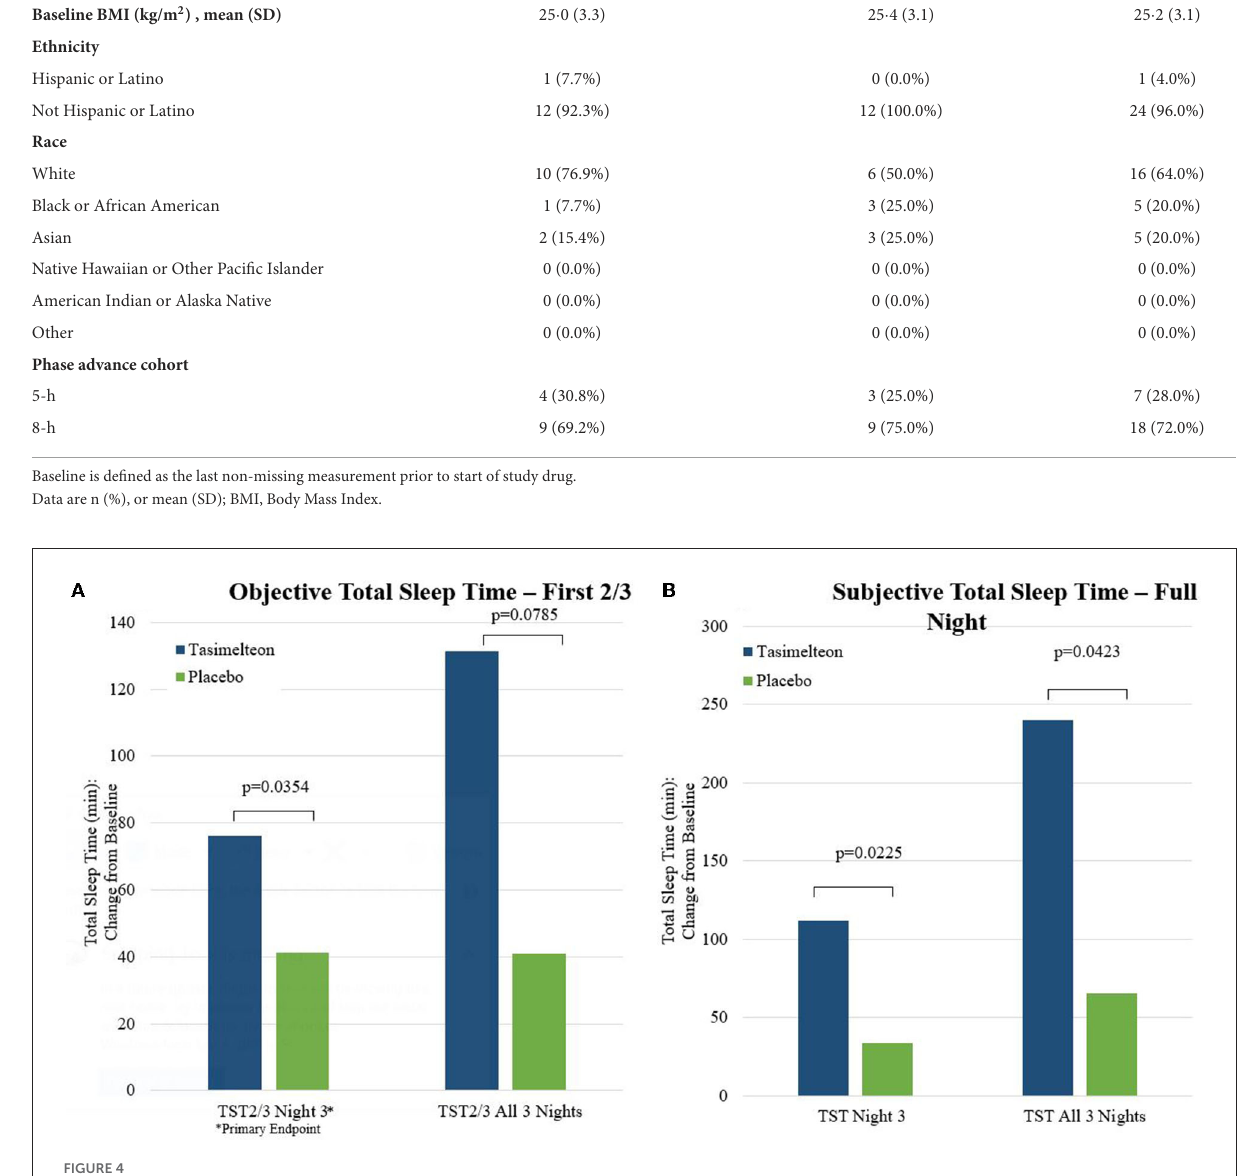
The safety assessments include adverse events (and serious adverse events); laboratory evaluations (hematology, blood chemistry and urinalysis values); vital signs; physical examinations and